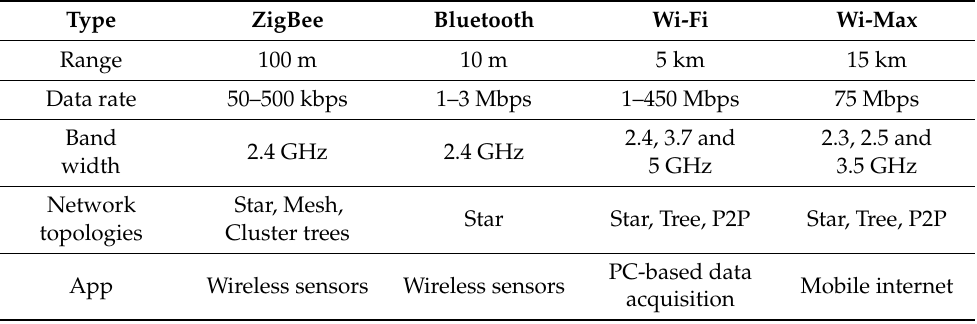
Table 1. Comparison of some commonly used wireless protocols for wearable healthcare applica- tions